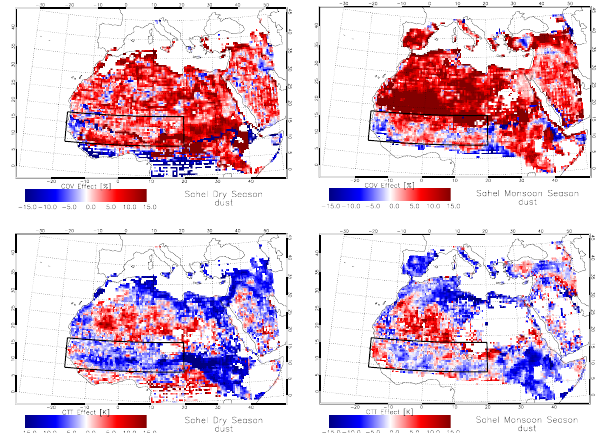
Fig. 8. Spatial distribution of mean changes of cloud cover (top row) and cloud top temperature (bottom row) with dust activity sea- sonally separated into Sahelian dry (left) and monsoon (right) sea- son as observed from